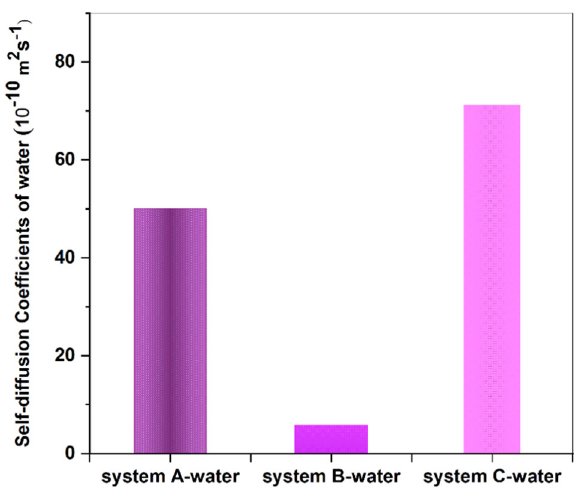
Fig. 6 The self-diffusion coef fi cient. The D i value of water molecules in different